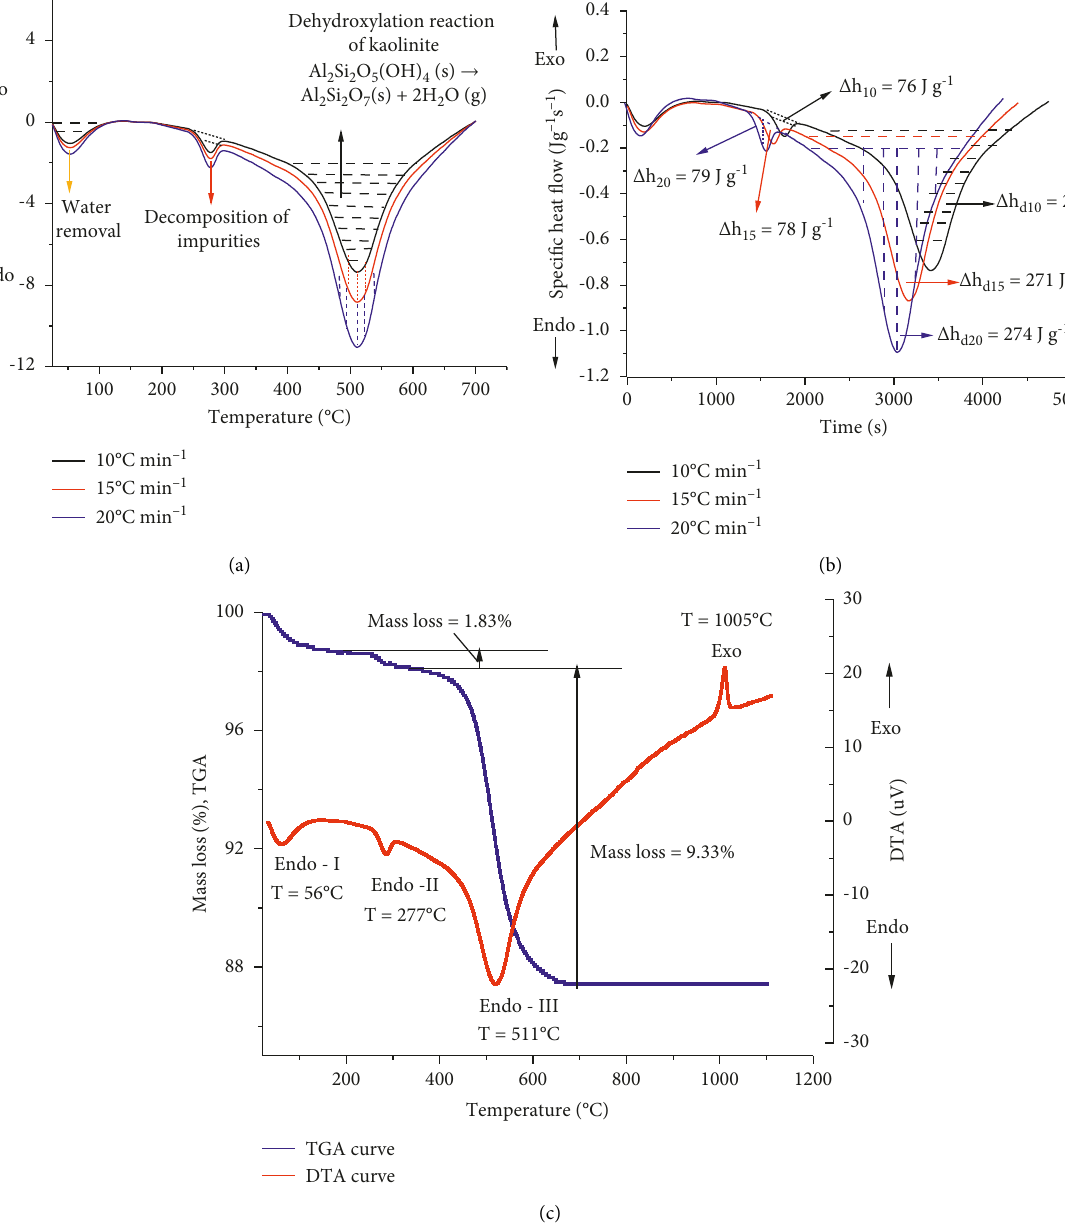
Figure 5: (a) DSC peaks, (b) specific enthalpy, and (c) TGA peaks of